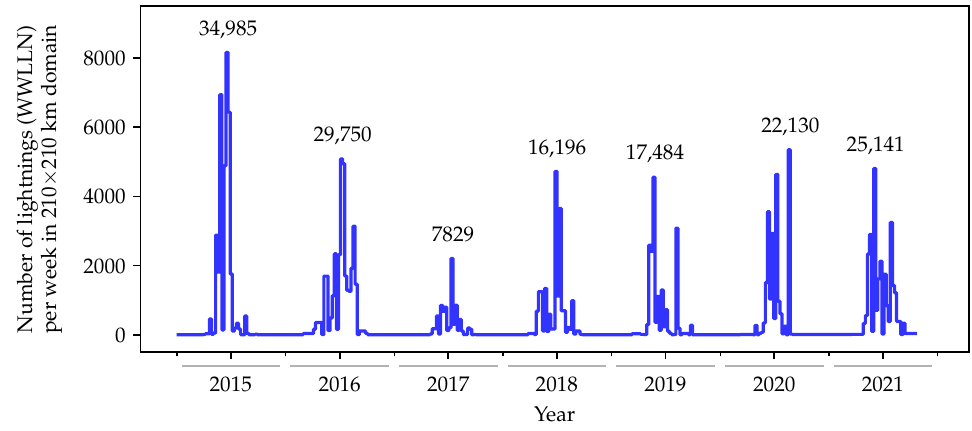
Figure 3. The number of lightnings detected by WWLLN in the area under consideration per week: year-by-year trend. Total number of the detected lightnings for each year is labeled on the chart.